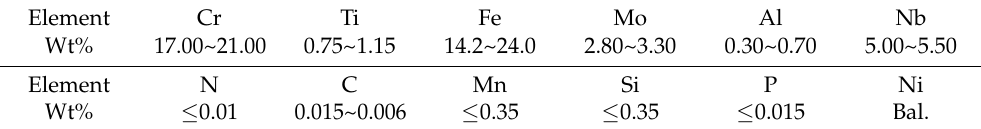
Table 1. Composition of Ni-based superalloy GH4169.